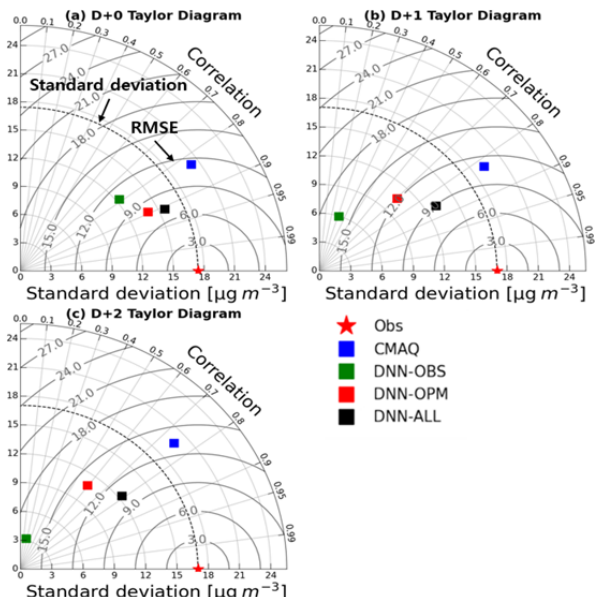
Figure 6. Taylor diagrams for D + 0 to D + 2 ( a – c ) of the CMAQ, DNN-OBS, DNN-OPM, and DNN-ALL models. In each diagram, the contour line connecting the x and y axes represents the standard deviation, and the dark gray contour line represents the RMSE. The smaller the RMSE, the higher the R value; the closer the standard deviation is to the standard deviation of the observation, the closer it is to the Obs ( (cid:63)